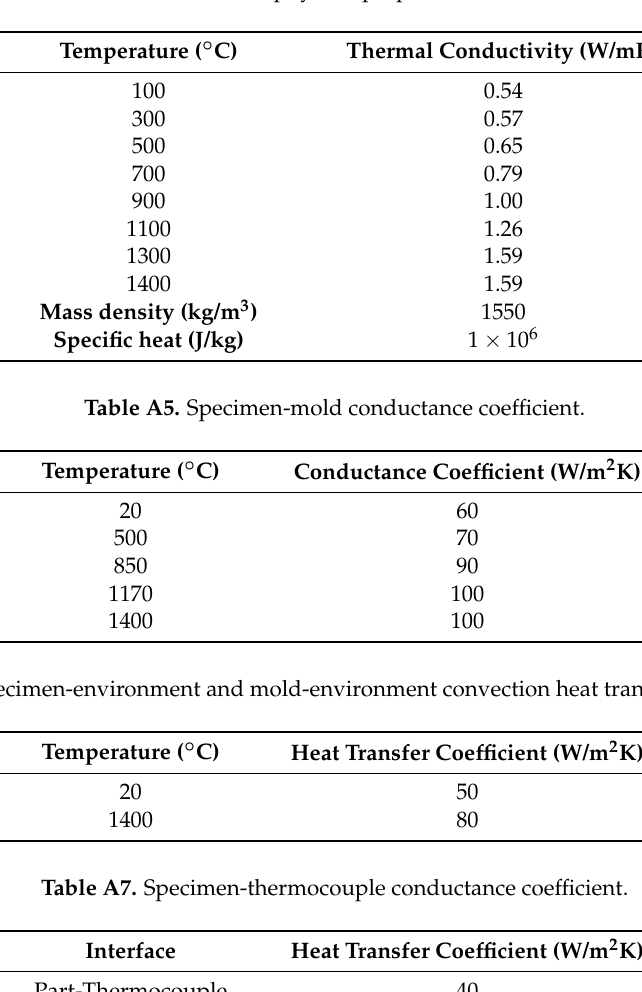
Table A4. Thermo-physical properties of the sand.